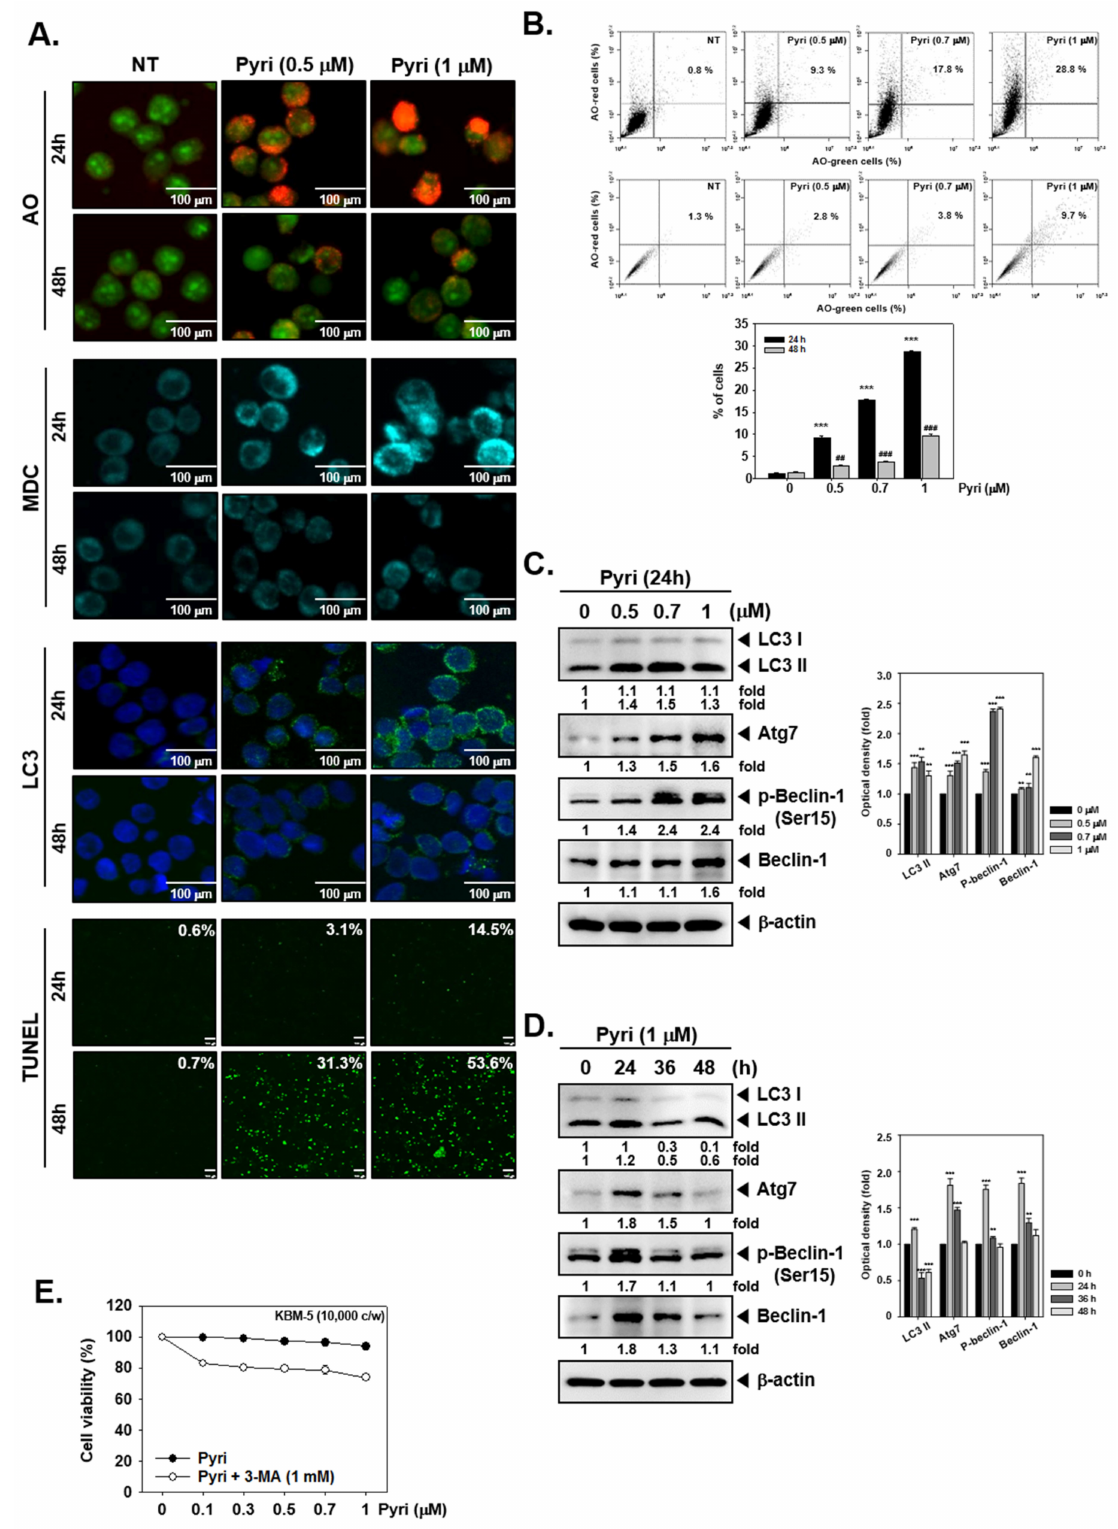
Figure 3. Pyri triggers substantial autophagy. ( A ) Representative images of Acridine orange (AO) ( first ) and Monodan- sylcadaverine (MDC) ( second ) staining of KBM5 cells following treatment with Pyri at the indicated concentration for the indicated time. For AO staining ( first ), red color intensity showed acidic vesicular organelles, representing the formation of autophagolysosomes. For MDC staining ( second ), punctate fluorescence in the cytoplasm indicates the formation of autophagic vacuoles. Representative images of LC3 ( third ) immunocytochemistry of KBM5 cells following treatment